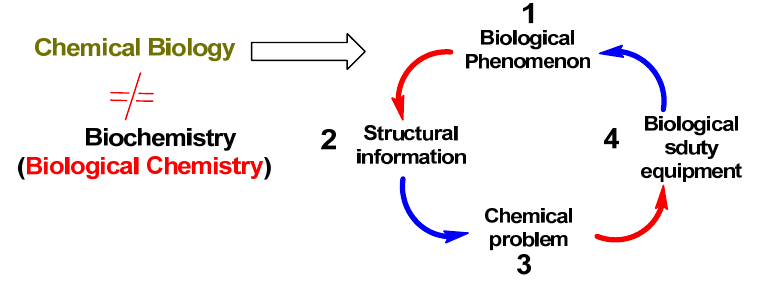
Figure 2. Principal stages of the study of chemical